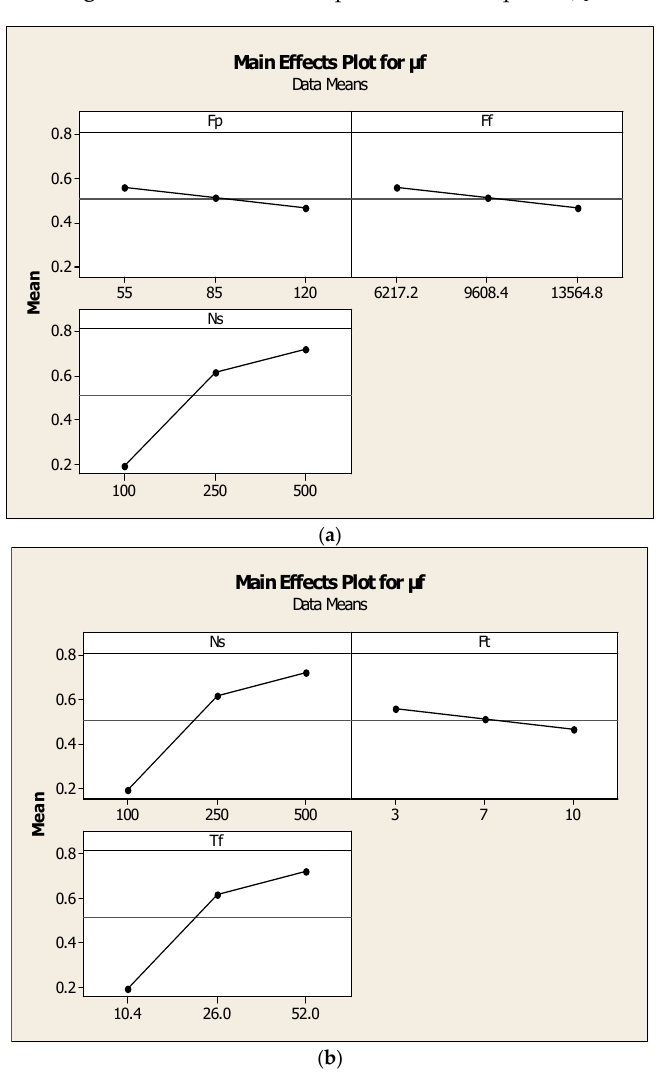
Figure 11. ( a ) Effect of speed, friction pressure. ( b ) Effect of speed, friction torque, and friction force on μ (cid:2916) .